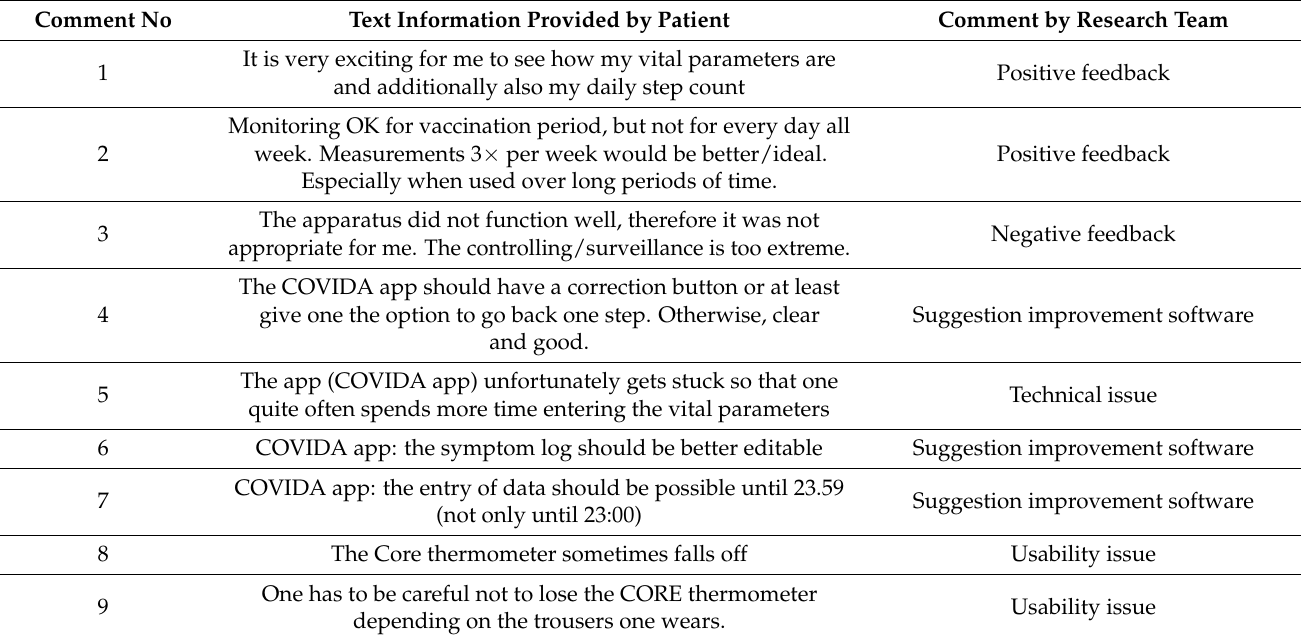
Table 3. Additional device-specific patient comments on different COVIDA desk components.